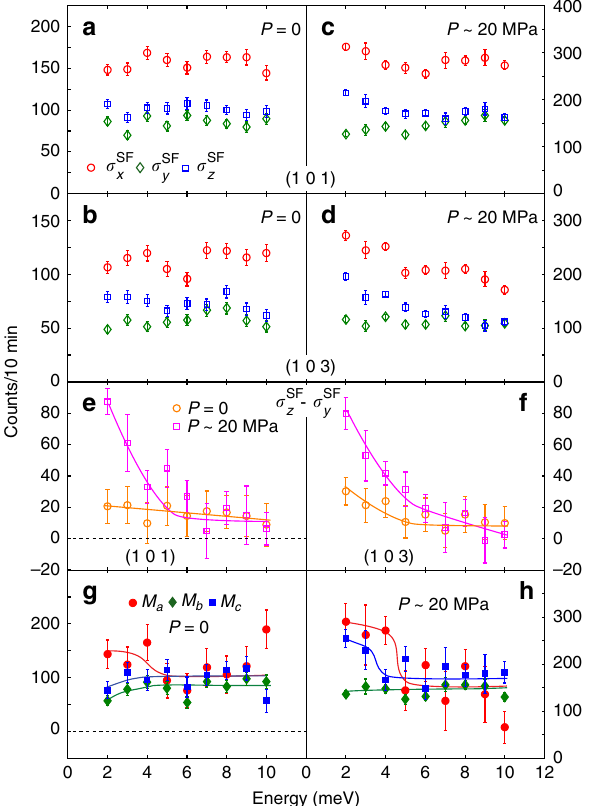
Fig. 2 The energy dependence of the neutron spin- fl ip magnetic scattering near T N without and with uniaxial pressure. Energy scans of σ SF σ SF σ SF P = x (red circle), y (green diamond), and z (blue square) under a , b 0 and T = 138 K 34 and c , d ~20 MPa and T = 145 K at the two AF wave vectors Q 1 = (1, 0, 1) and Q 2 = (1, 0, 3). e , f Comparison of P = 0 and P ≈ 20 MPa ð σ SF z (cid:2) σ SF y Þ at (1, 0, 1) and (1, 0, 3). g , h Energy dependence of M a , M b , and M c extracted from the raw data in ( a – d ). The solid lines are guides to the eyes and the error bars represent 1 standard